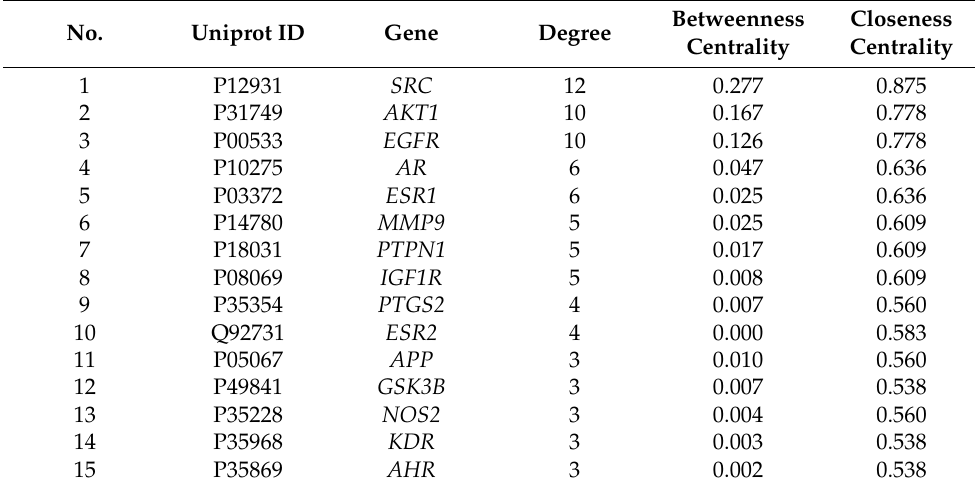
Figure 3. Protein–protein interaction network of potential anti-obesity target genes of p -synephrine. The size and red hue of a node represent its significance within the network. Table 3. Hispidulin anti-obesity key targets identified based on PPI network topological analysis.